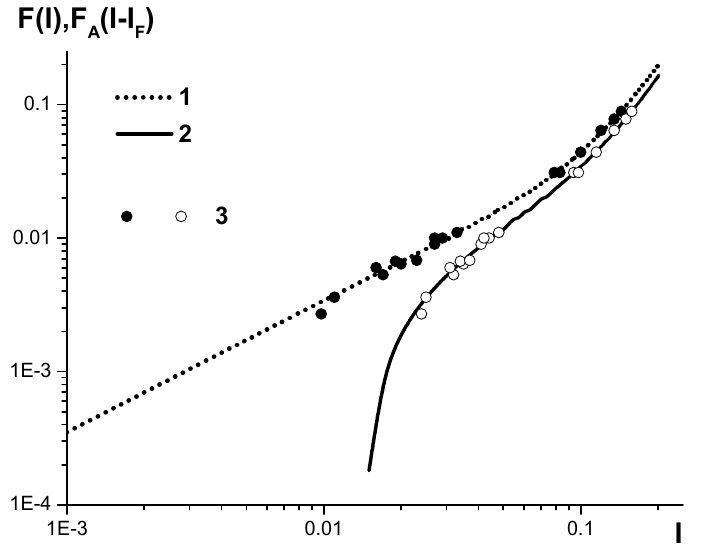
Figure 7. Calibration curves to determine phosphorus concentration in low- and medium-alloyed steels on SPAS-05 emission spectrometer, serial number № 18; 1—with accurate accounting for plasma background radiation; 2—without accurate accounting for plasma background radiation; 3—nameplate concentration values P in a SS.